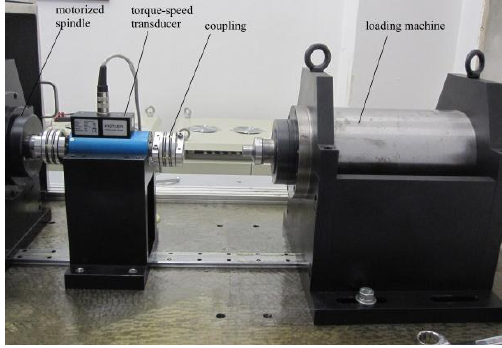
Figure 6. Loss experimental device.